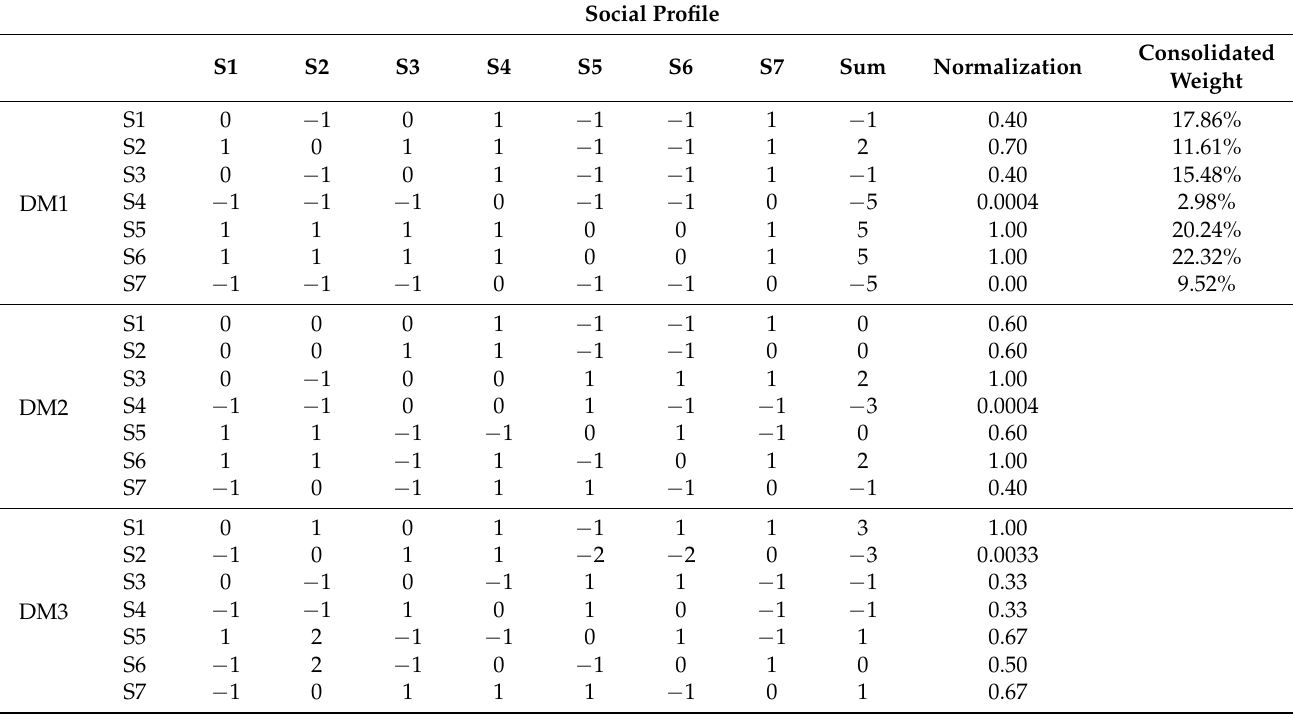
Table 7. Paired comparison between the subcriteria of the “Social Profile”.